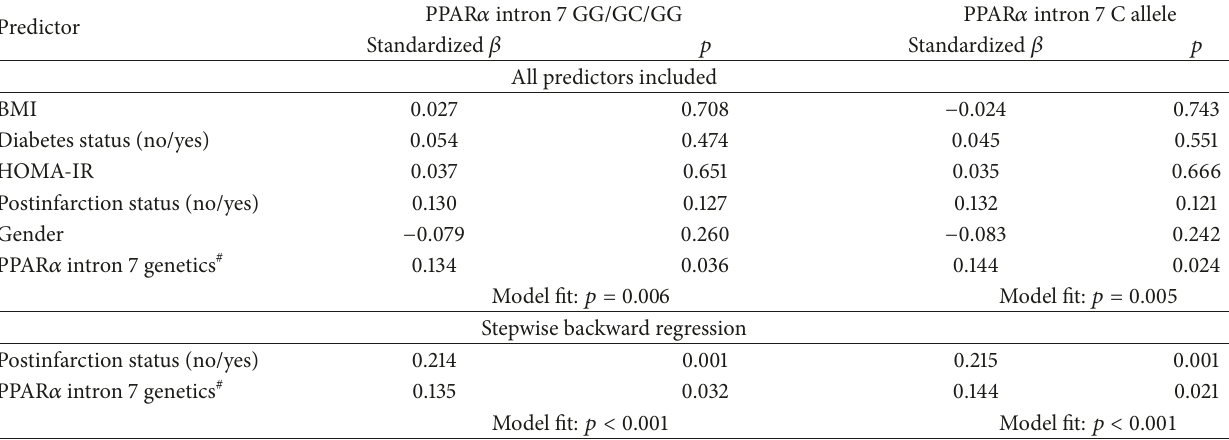
Table 6: Multiple regression analysis of PPAR 𝛼 intron 7 G/C genotypes and C allele and serum fetuin-A concentration (𝑛 = 244) . Predictor